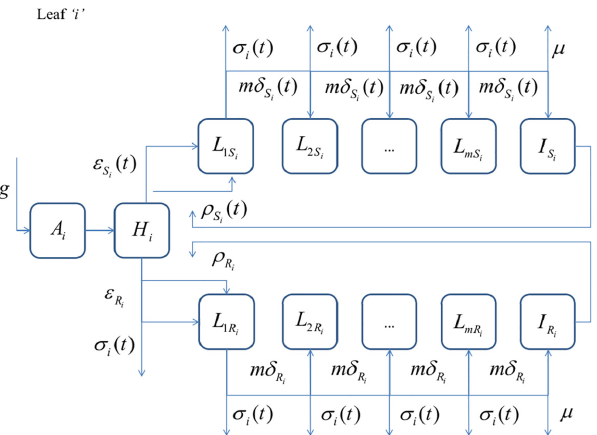
Fig 2. Flow diagram of the disease sub-model for leaf layer i . Healthy leaf area not lost by senescence (rate σ ( t )) was infected at rate ε by primary inoculum (ascospores) and at rate ρ from secondary inoculum (pycnidiospores). The mean infectious period was 1/ μ and the mean latent period was 1/ δ . The pathogen model included two strains; a fungicide sensitive strain, S , and a fungicide resistant strain, R . Parameters δ , ρ and ε for the sensitive strain were reduced according to the fungicide dose response